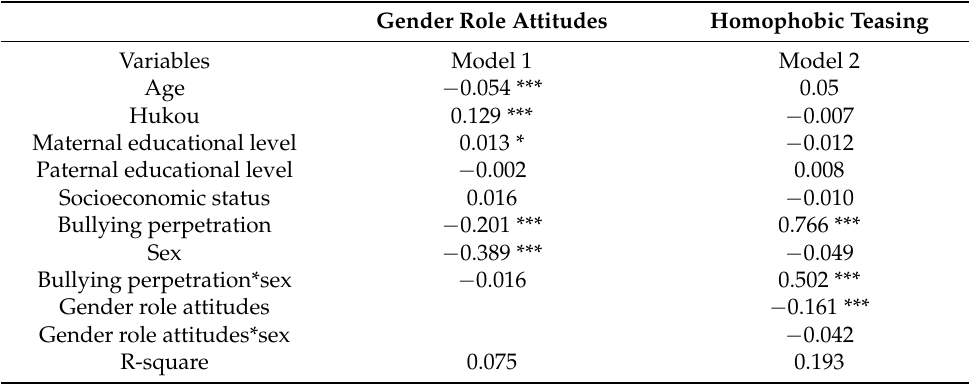
Table 3. Indirect and total effects between variables (standardized